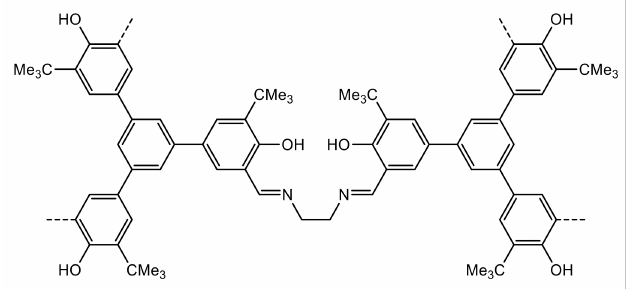
Figure 14. Schematic representation of the metal coordination points of COF- salen